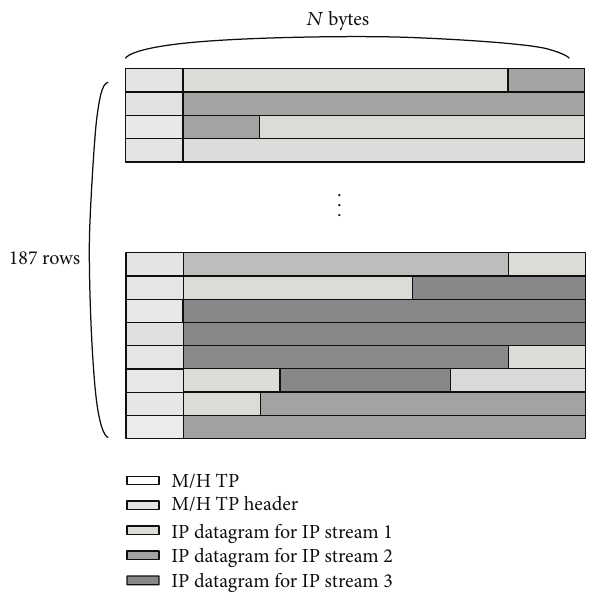
Figure 1: RS frame internal structure